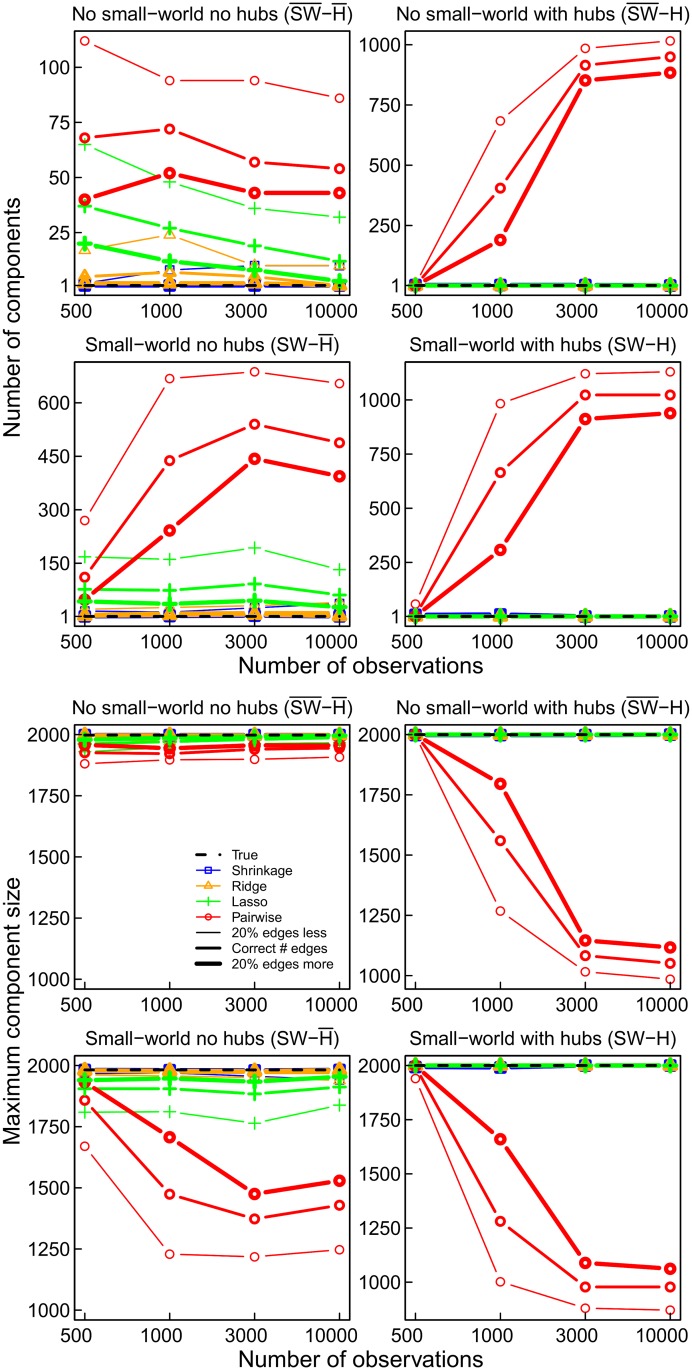
The number of components (upper) and the size of the largest component (lower) obtained for the four networks and estimation methods.